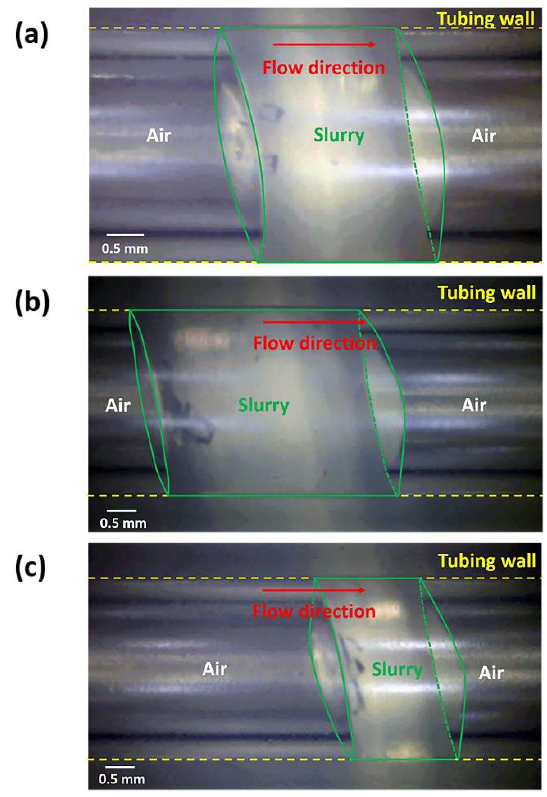
Figure 2. In-line microscope images of crystals in the slurry slug (in the center) with a slug aspect ratio of about ( a ) 0.8, ( b ) 1.2, and ( c ) 0.6. The experimental details are in Table 1, Conditions 1, 2, and 3, respectively. The flow direction is from left to right. The green line delineates the outline of the slurry slug. The front of the slurry slug resembles a projecting semicircle indicating the surface hydrophobicity of the inside tubing wall. The front is protruding more than the tail end [57]. Larger liquid flow rate and smaller air flow rate would reduce the length of the slurry slug [58]. Scale bar: 0.5 mm. The images of representative product crystals are in Figures 3–5, with size statistics in Table 2.